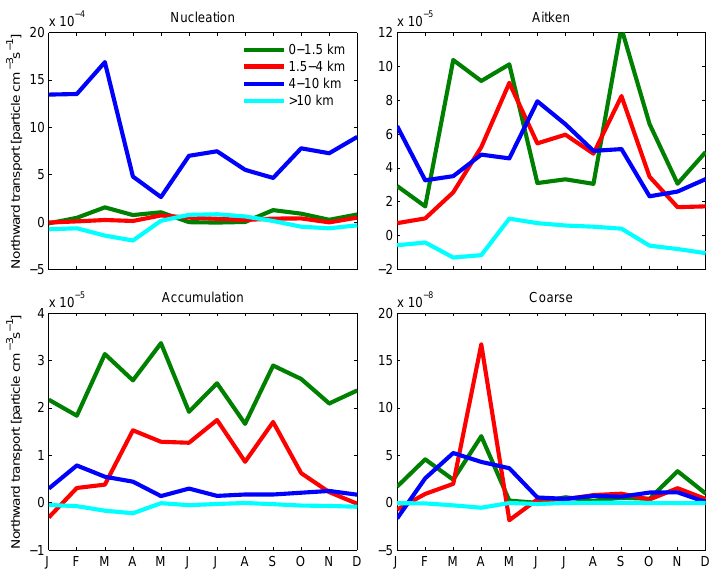
Figure 9. Monthly and Arctic mean aerosol number tendency due to transport within each of four vertical layers between (1) 0–1.5km, (2) 1.5–4km, (3) 4–10km, and (4) above 10km for the simulation NEWSCAV + COAG for the entire troposphere north of 66 ◦ N. Summation of the four layers for any given month and size range yields the transport tendency shown in Fig. 8. Positive values indicate a net northward transport into the